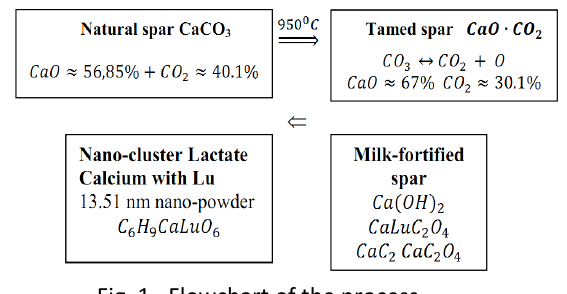
Fig. 1 . Flowchart of the